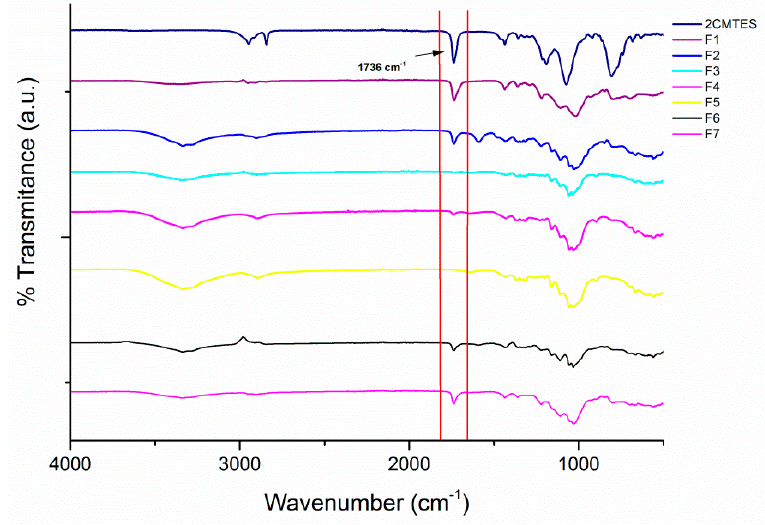
Figure 3. FTIR spectra of 2-(carbomethoxy)ethyltrimethoxysilane (2CMETS) and functionalized CNCs (F-CNCs) prepared in different conditions.